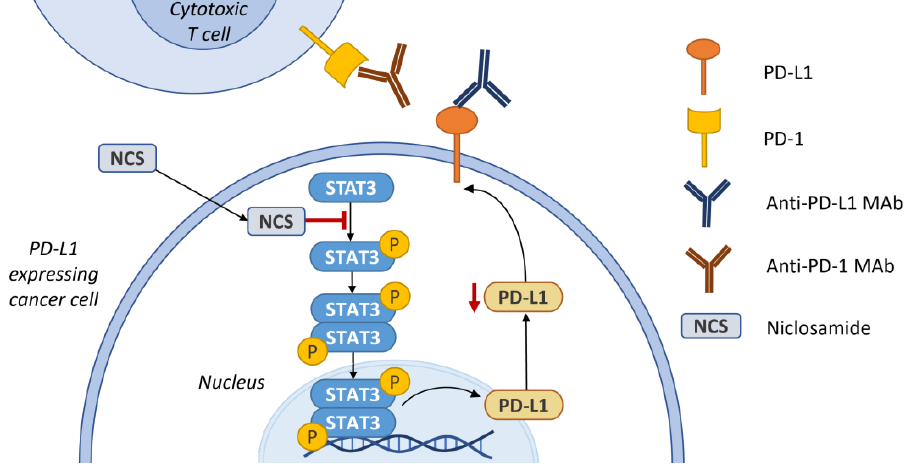
Figure 7. Synergistic activity of niclosamide with immune checkpoint inhibitors e.g., anti-PD-L1 or anti-PD-1 monoclonal antibodies. Niclosamide suppresses phosphorylation of STAT3 and thus downregulates the expression of PD-L1. Scheme was created according to [104,161]. Luo et al. showed that niclosamide, as a suppressor of STAT3 phosphorylation, downregulates PD-L1 expression in non-small cell lung cancer cells. Authors further proved this downregulation related to the blockage of STAT3 phosphorylation and fur- ther binding to the PD-L1 promoter. Thus, such a combination therapy of niclosamide and PD-1/PD-L1 inhibition can represent a possible strategy to enhance immunotherapeutic efficacy [104]. Recently, downregulation of PD-L1 expression induced by niclosamide was also demonstrated in pancreatic cancer cells [162].